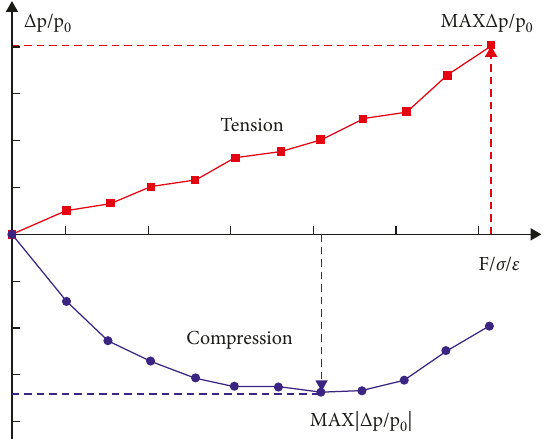
Figure 2: Typical sensing behavior of self-sensing concrete under compression and tension.